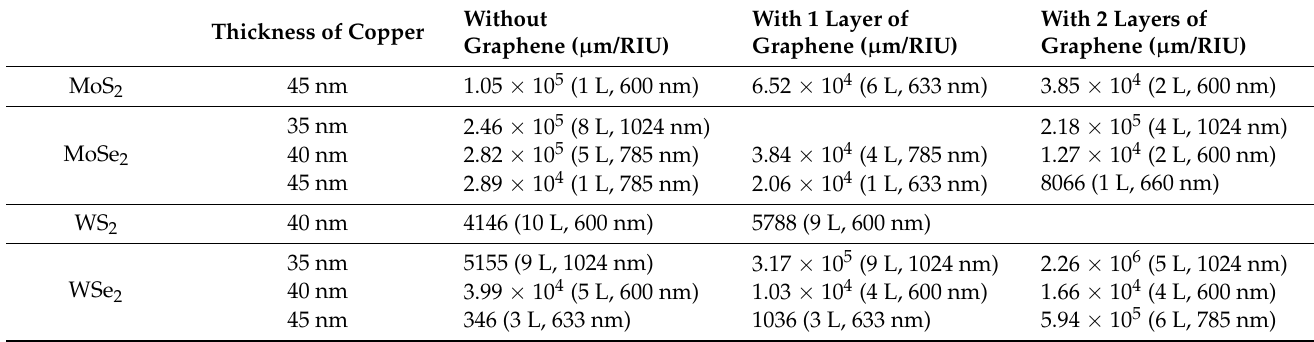
Table 2. Sensitivity values ( µ m/RIU) by graphene layers with MX 2 materials. In the brackets number of MX 2 layers and excitation wavelength are indicated.